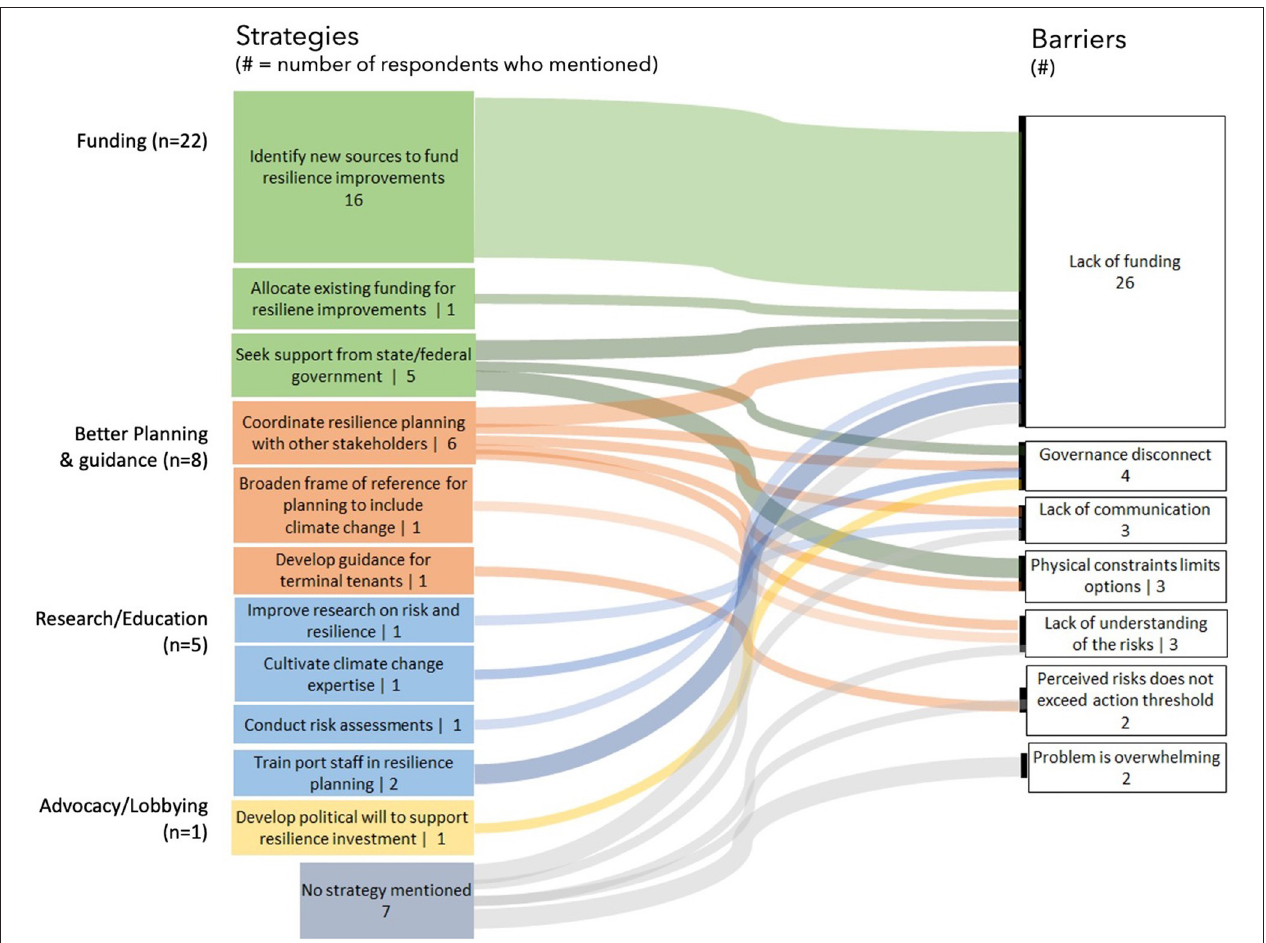
FIGURE 2 | Seven barriers connected to the identified distinct strategies: Funding (3) (green); Better Planning/guidance (3) (blue); Research/Education (4) (yellow); Advocacy and lobbying (1) (orange); No strategy mentioned (gray). The diagram shows how each of these strategy categories was discussed as a way to overcome the seven major barriers identified by interviews, depicted on the right.